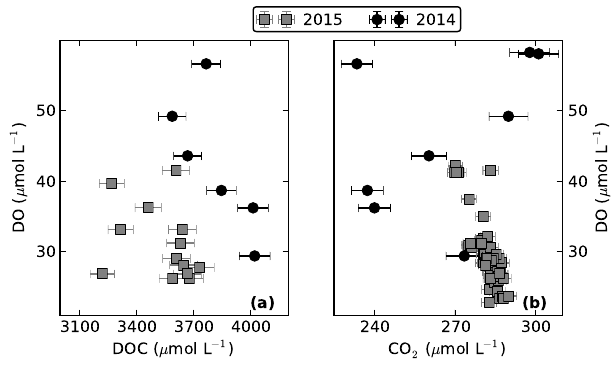
Figure 5. DO vs. DOC (a) and DO vs. CO 2 (b) reveal a weak linkage between these parameters in the river. The legend applies to both